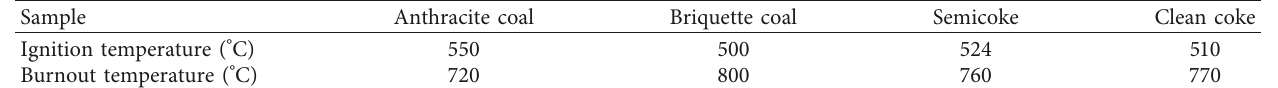
Figure 1: Thermogravimetric curve of the clean coke sample. (a) TG-DTG curve. (b) TG-DSC curve. Table 5: Ignition temperatures and burnout temperatures of coal-based fuel.